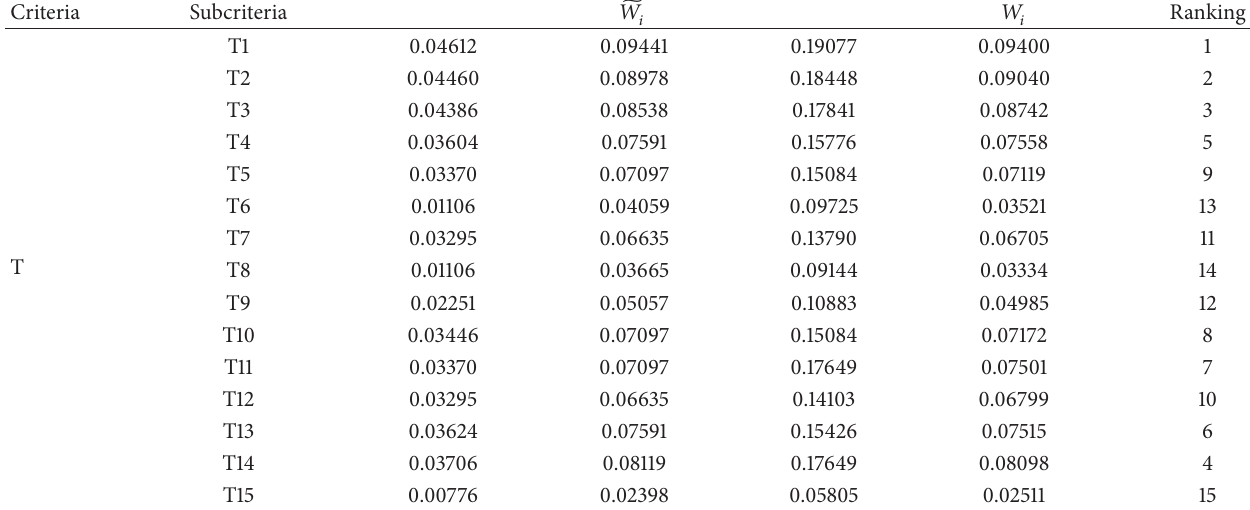
Table 13: Fuzzy and crisp weights and ranking scores for subcriteria in technical